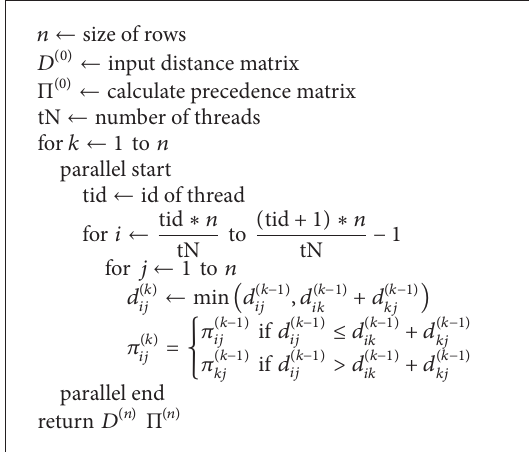
Algorithm 2: OpenMP pseudocode for the all-pairs-shortest-path